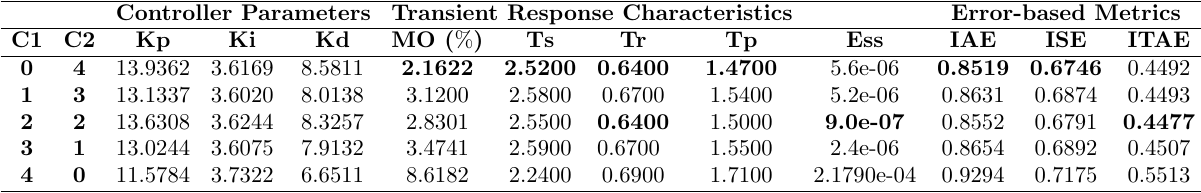
Table 4. Effect of acceleration parameters on system dynamic response, steady-state error and performance metrics.